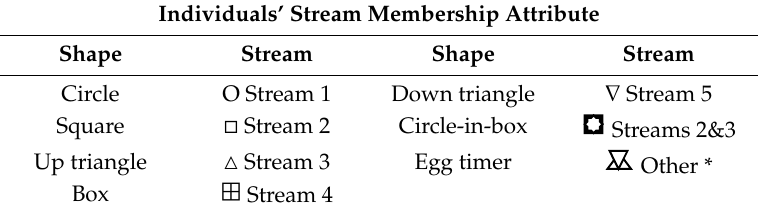
Figure 4. Phase 1 sociogram for preferred idea sharing (strength of tie = 3 and organisation and stream attribute display). *Other refers to a combination of two or three different streams. Table 3. Attribute of individuals